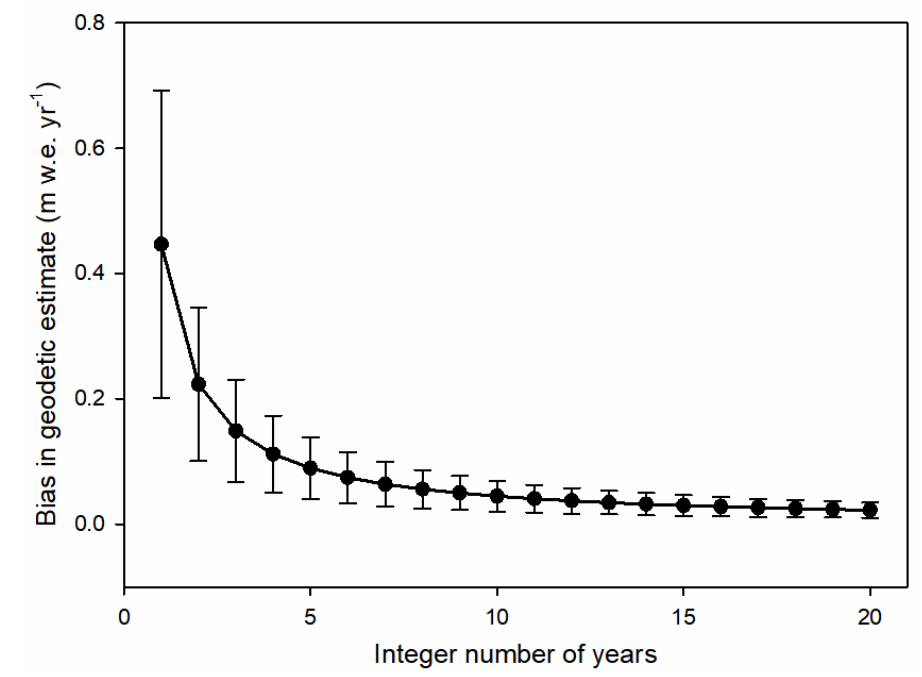
Figure 4. The impact of X-band radar penetration in mass balance estimation versus integer number of years for the study period. For visualization, the error bars indicate five times the estimated uncertainties.